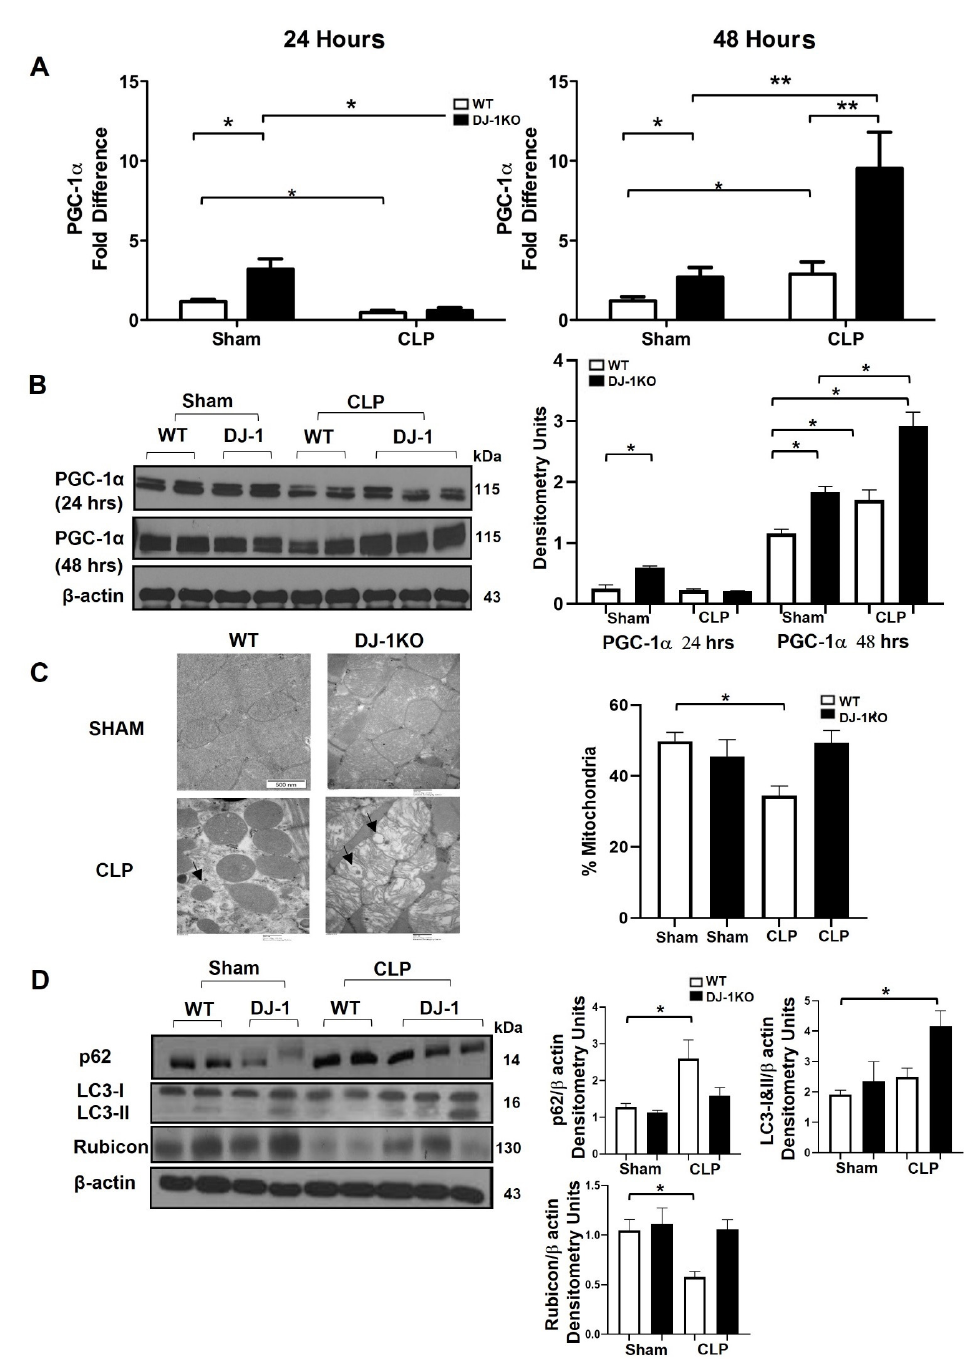
Figure 7. DJ-1 deficiency increases autophagy and decreases apoptosis. ( A ) Bars are mean + SEM of PGC-1a mRNA expression/18S in myocardium of WT and DJ-1KO mice at 24 and 48 h post-CLP or sham operation. n = 9–11/group. ( B ) Representative Western blots of PGC-1a protein expression in the myocardium of WT and DJ-1KO mice at 24 and 48 h post-CLP or sham operation. Densitometry units are shown. n = 3/group. ( C ) Representative transmission electron microscopy micrographs depicting double stranded autophagosomes (back arrows) and mitochondria in the myocardium of WT and DJ-1KO sham and 48 h post-CLP. Scale bar = 500 nm. Bars are mean + SEM of % mitochondria (per unit area cytoplasm). ( D ) Representative Western blot showing expression of p62, LC3-I, LC3-II and Rubicon protein in myocardium of WT and DJ-1KO mice at 24 and 48 h post-CLP or sham operation. Densitometry units are shown. n = 3/group. * p < 0.05, ** p <